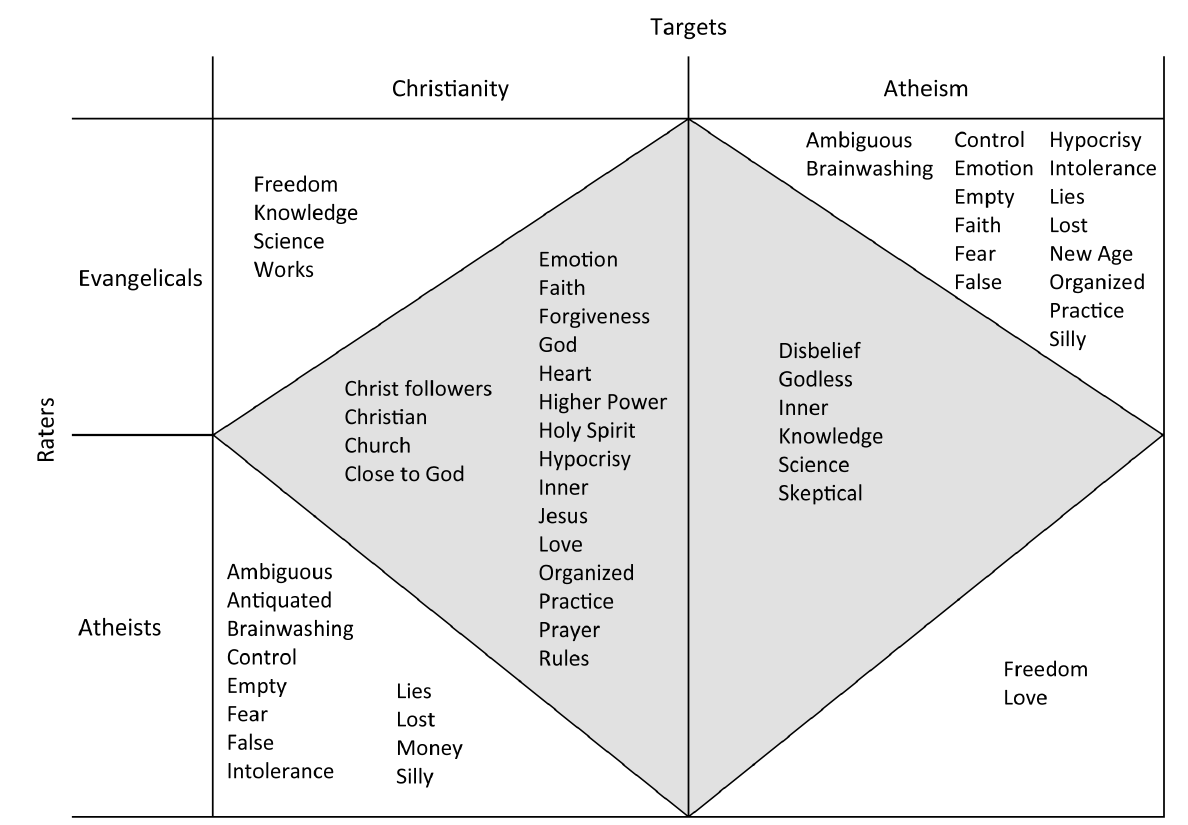
Figure 1: Words evangelicals and atheists rated as at least “moderately” applying to Christianity or atheism (rating ≥ 3, rounded). Areas shaded gray signify words both groups indicated applied at least “moderately” to Christianity or